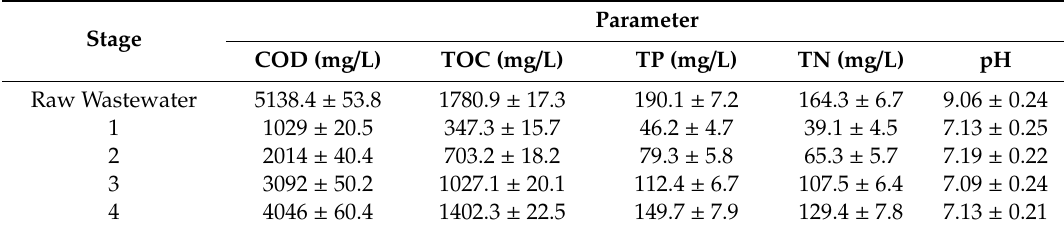
Table 1. Characteristics of dairy wastewater used in the experiment.